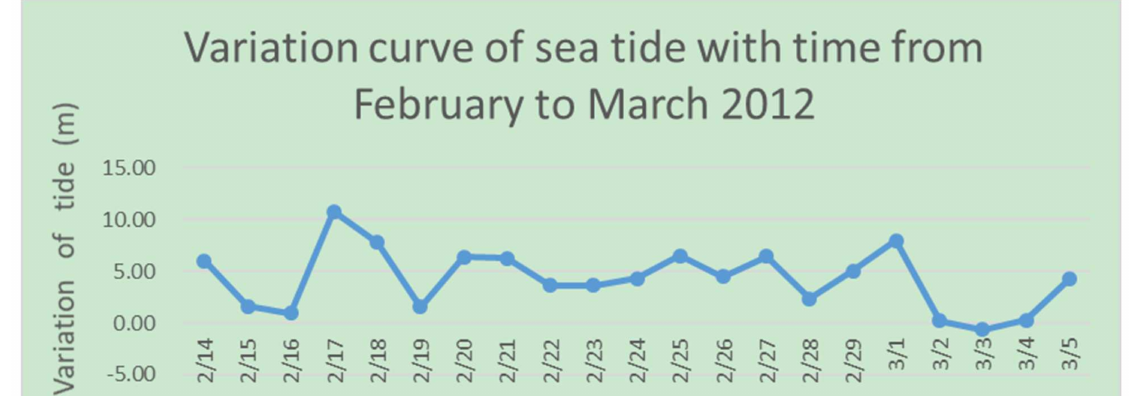
Figure 11. Altitude change of ice